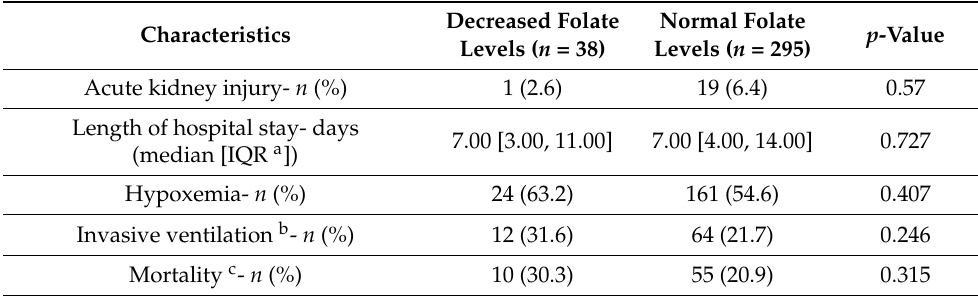
Table 4. Outcomes of COVID-19 hospitalized patients.